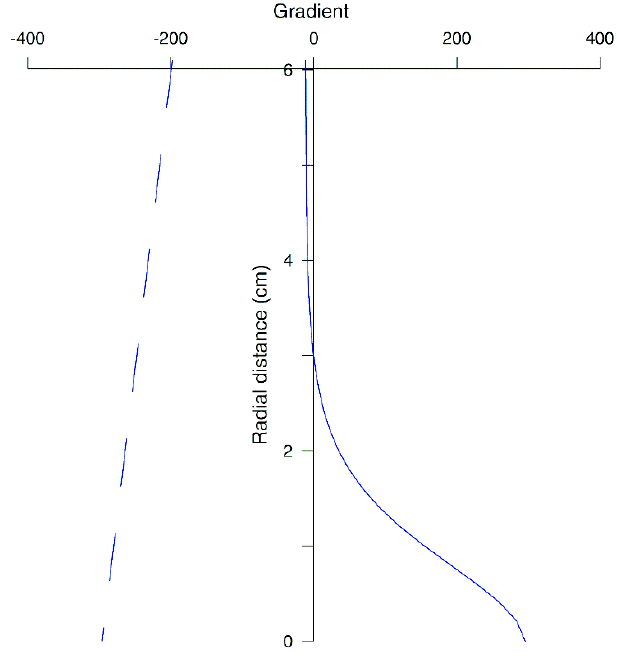
Figure 8. Comparison of the matric potential gradient (continuous line) to centrifugal gradient (dash lines) for lithotype C, run with cake SF210 at a centrifugal driving force of 57 × g . The graph shows that the centrifugal gradient overwhelms the matric potential gradient. This is verified for all the combinations of granular materials and centrifugal driving forces with differences of gradients measured at the top of the sample ranging from 30 to 200 (the case of this figure).